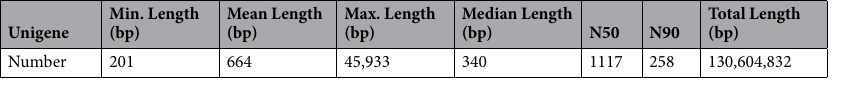
Table 1. Summary statistics of Ruditapes philippinarum transcriptome assembly using Trinity software.